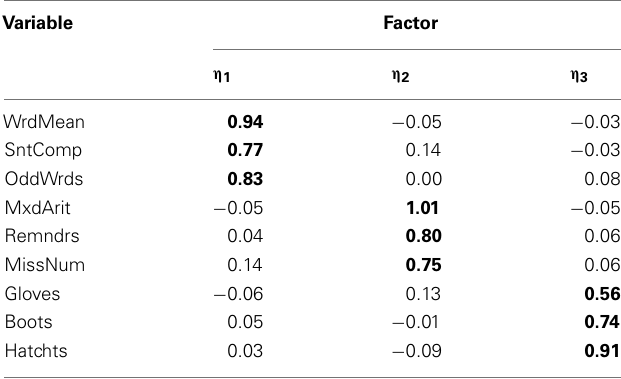
Table 2 | Population factor loading matrix.